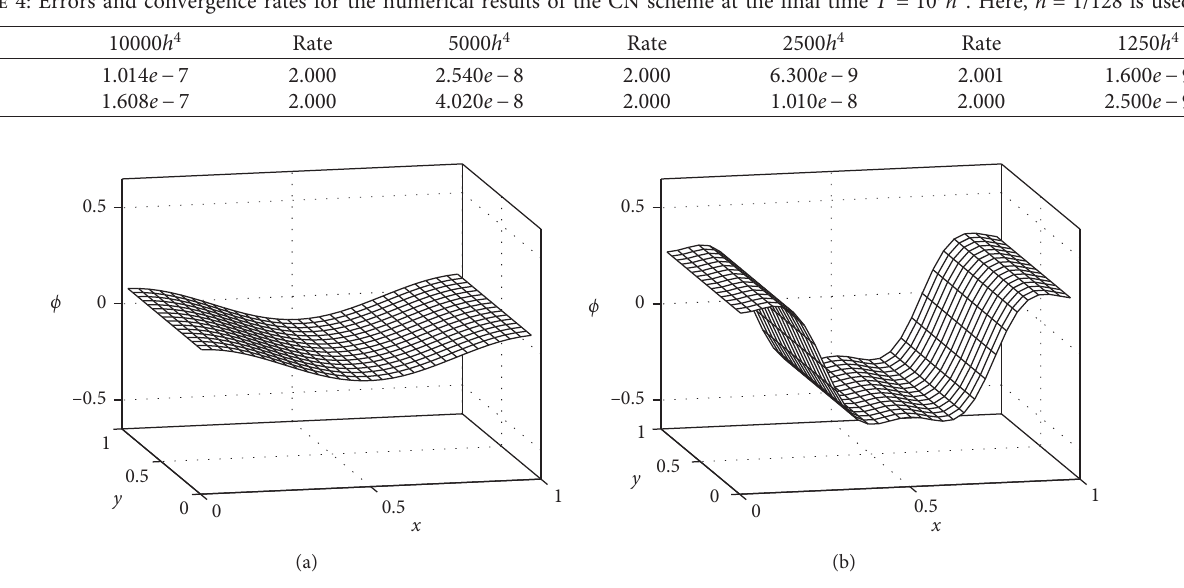
Figure 5: (a, b) The initial condition and the reference solution at t � 10 7 h 4 ,